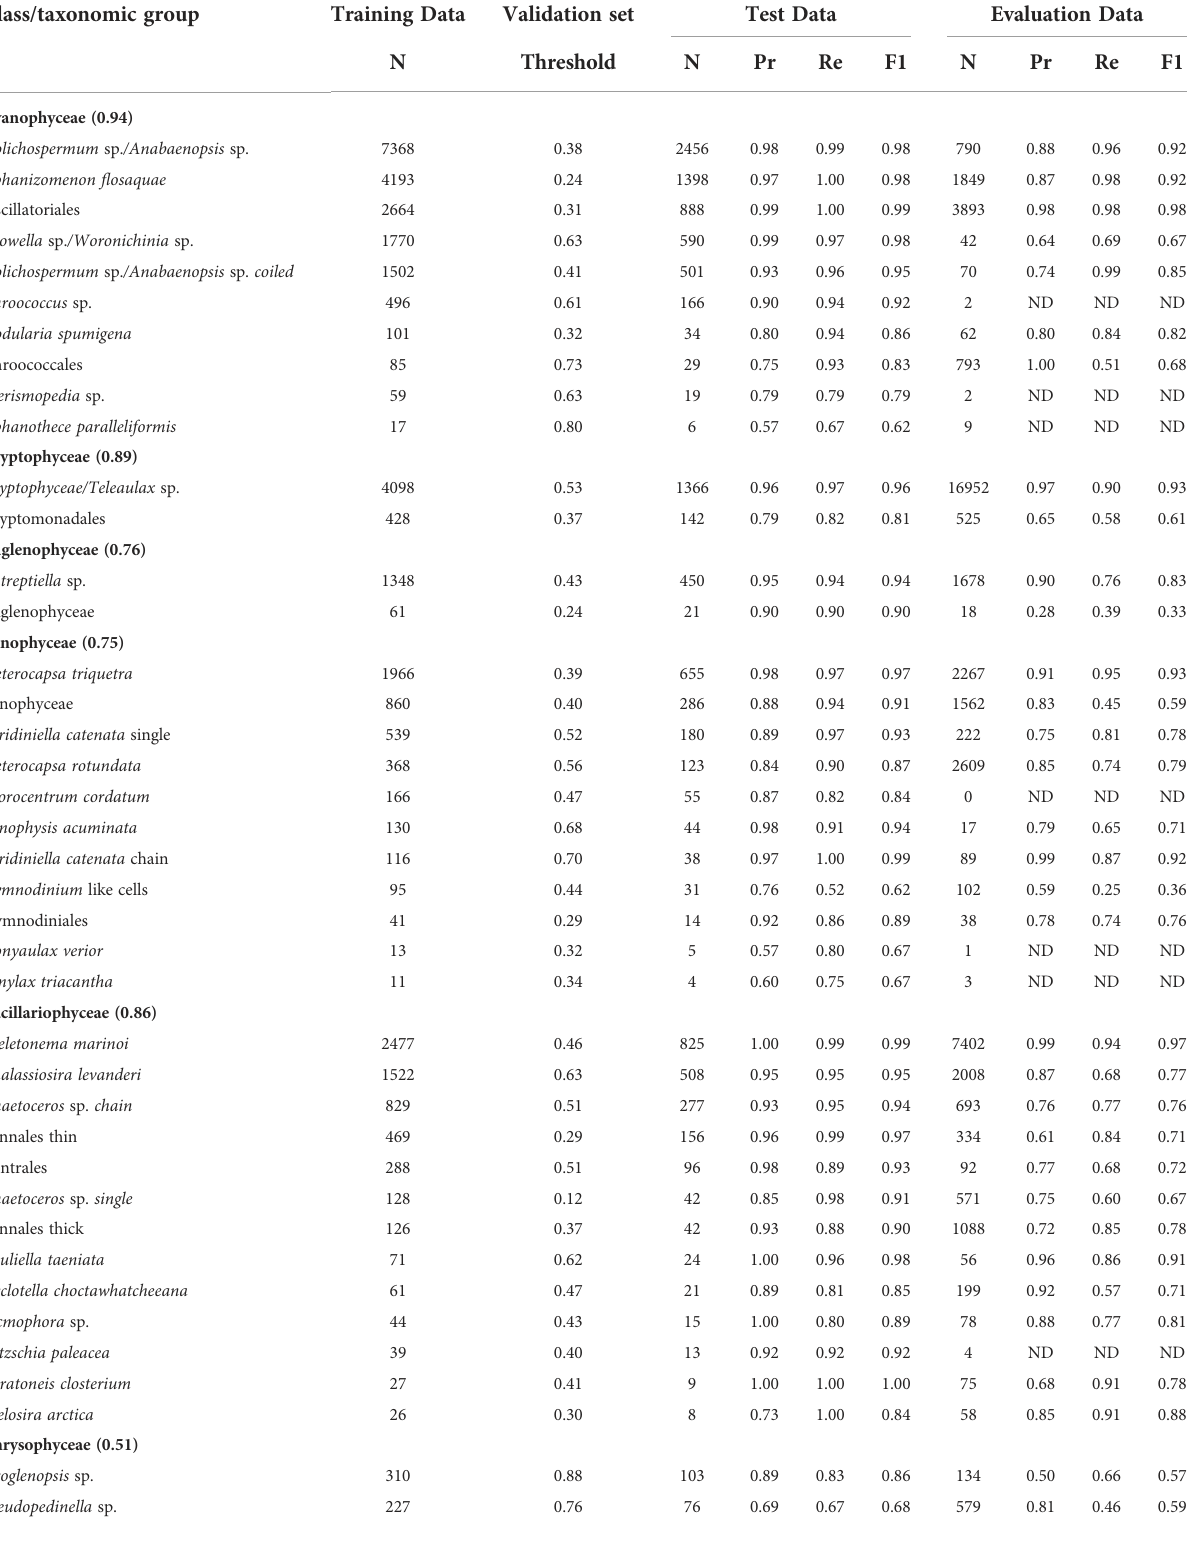
TABLE 1 The table represents the class-speci fi c classi fi cation metrics for the Test Data and for the Evaluation Data (Pr, precision; Re, Recall; F1, F1-score; N, number of images).